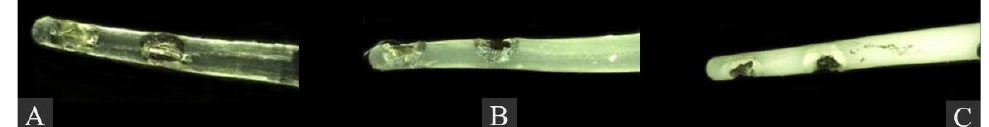
Figure 3. ( A ): pure silicone electrode array without DEX (0%); ( B ): electrode array containing 1% DEX (16 ng/day delivery rate); ( C ): electrode array containing 10% DEX (49 ng/day delivery rate). Adapted from an open-access source: [36] .